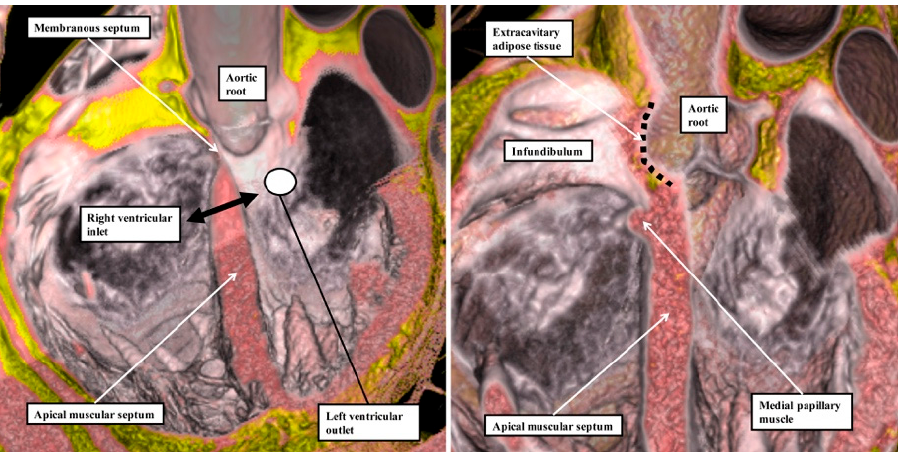
Figure 5. These images were prepared by virtual dissection of a cardiac computed tomographic dataset. The left -hand panel shows that the basal and inferior part of the ventricular septum interposes between the inlet of the right ventricle and the subaortic outlet of the left ventricle. The right -hand panel shows that the infundibulum of the right ventricle is a free-standing myocardial sleeve. By virtue of the presence of this free-standing sleeve, there is no “outlet septum” in the normal heart.